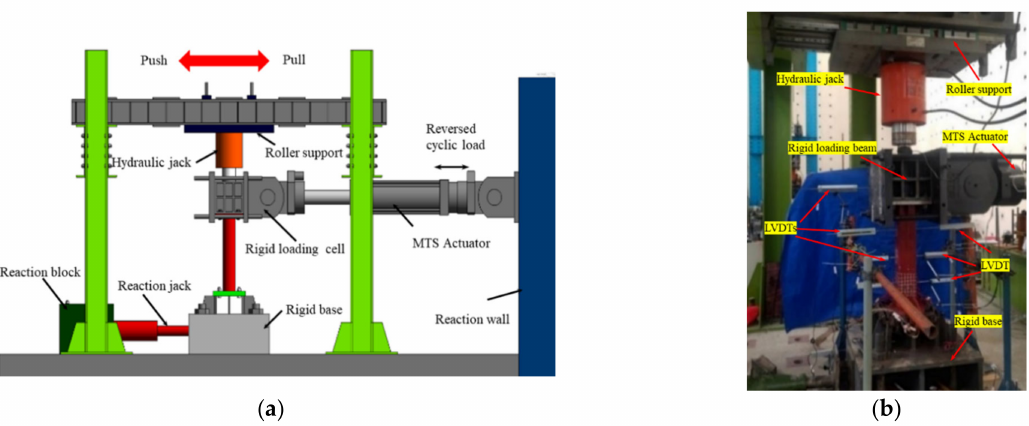
Figure 2. ( a ) Diagram of test setup of test setup for reversed cyclic loading; ( b ) specimen photograph of test setup for reversed cyclic